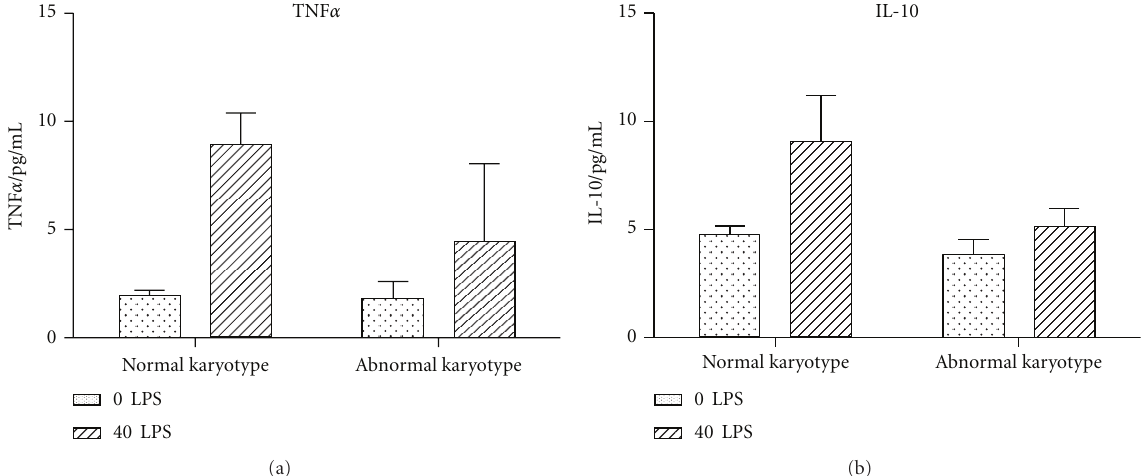
Figure 2: Levels of cytokines in monocytes ( n = 12 with normal karyotype and n = 14 with abnormal karyotype). There was no significant di ff erence in any of the intracellular levels of cytokines.